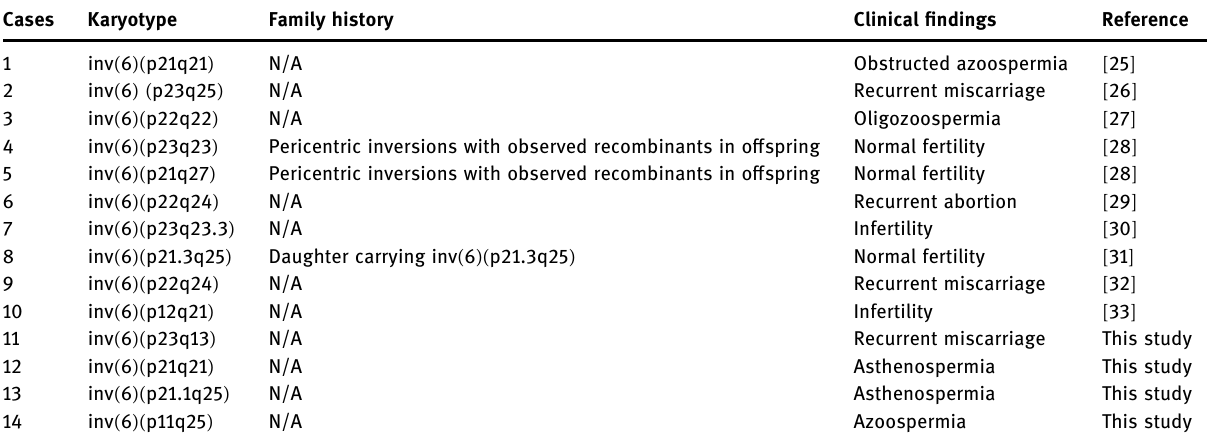
Table 1: Clinical fi ndings in the couples ’ with a male partners carrying chromosome 6 inversion